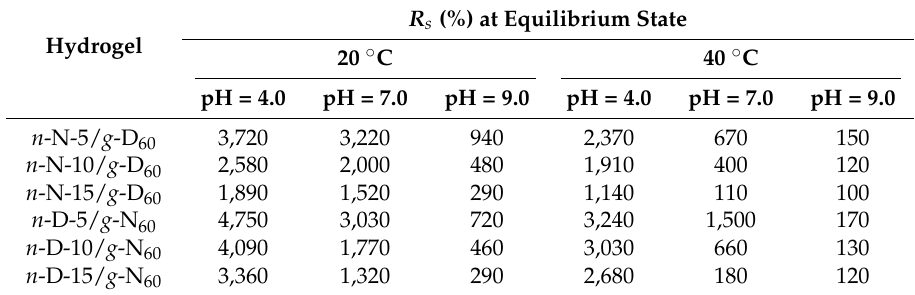
Table 3. Comparison of swelling behaviors of different comb-type grafted hydrogels made from PDMAEMA and